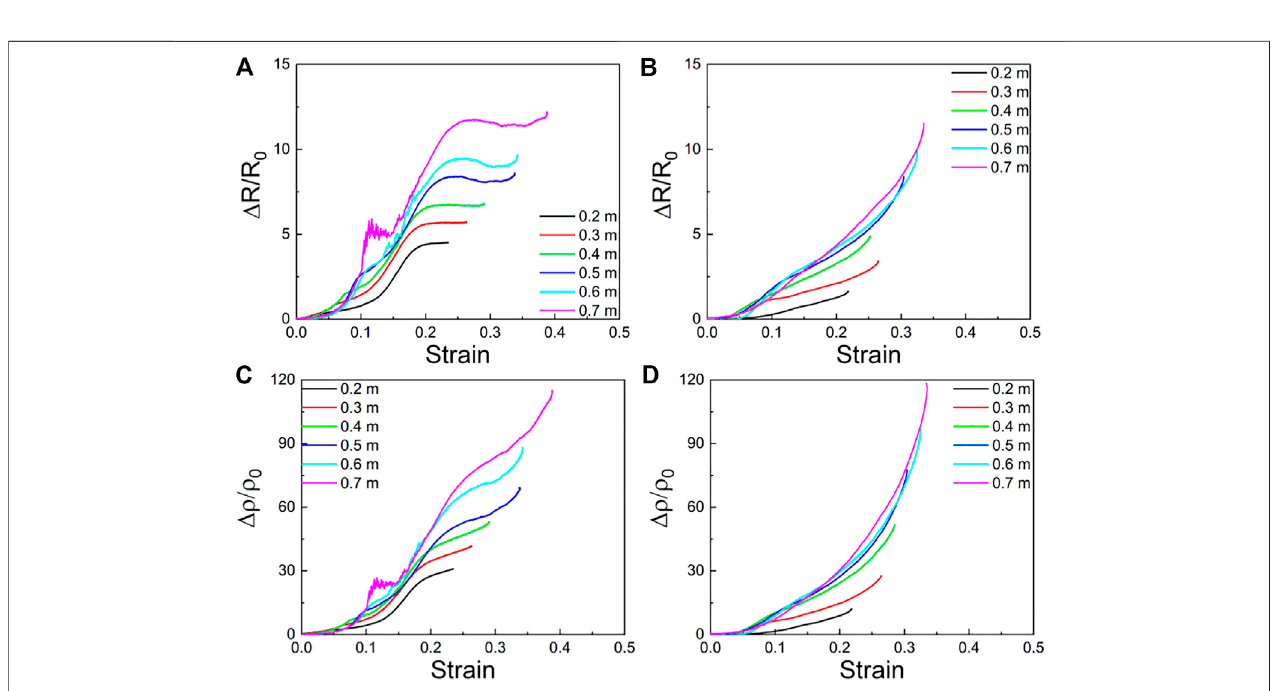
FIGURE 7 | Response of (A) resistance and (C) resistivity to compressive strain. (B,D) illustrated the results with a magnetic fl ux density of 0.3 T.